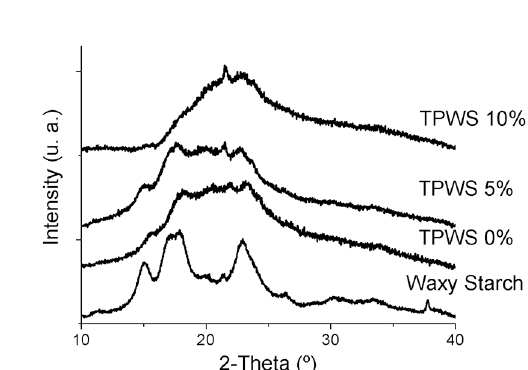
Figure 3. X-ray diffraction patterns for waxy starch, TPWS 0%, TPWS 5%, and TPWS